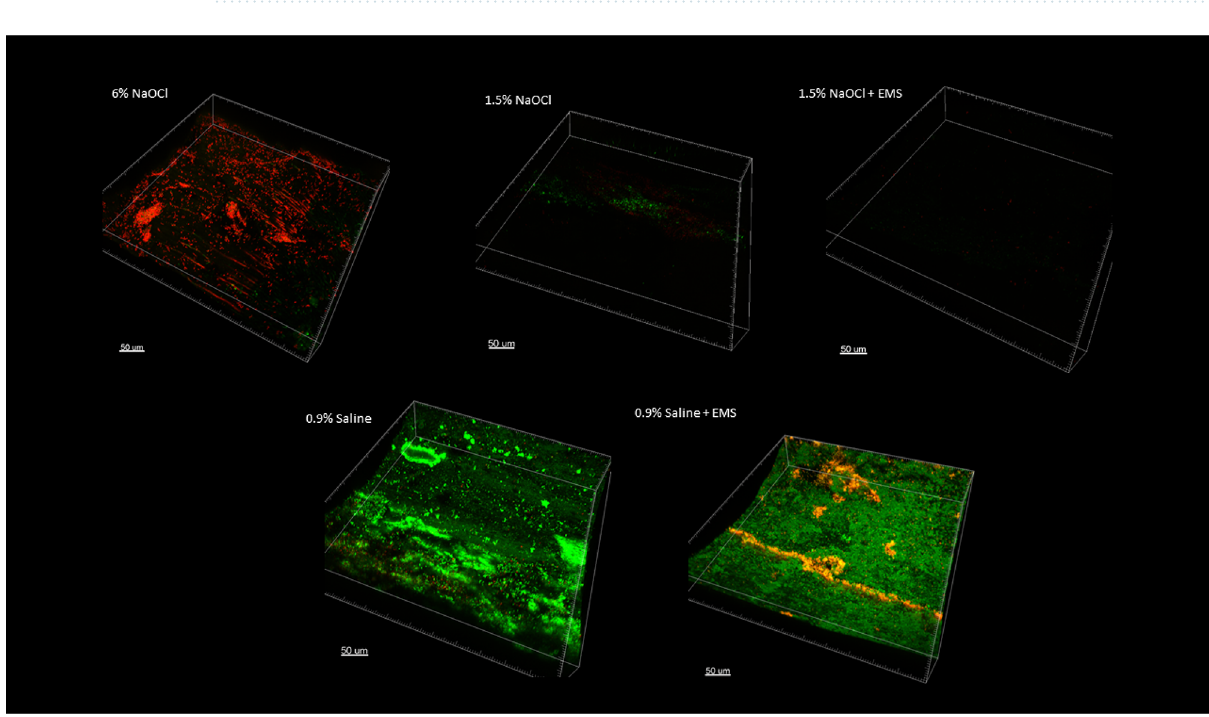
Figure 7. 0.5 mm stack 6 mm coronal to the